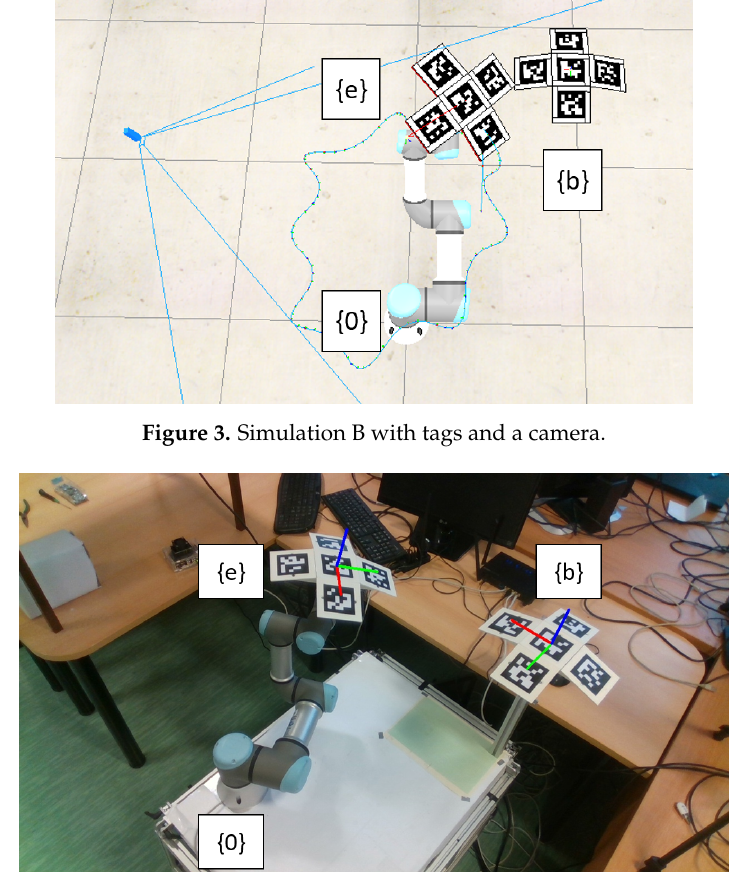
Figure 4. Experiment A setup; point of view of camera 2.